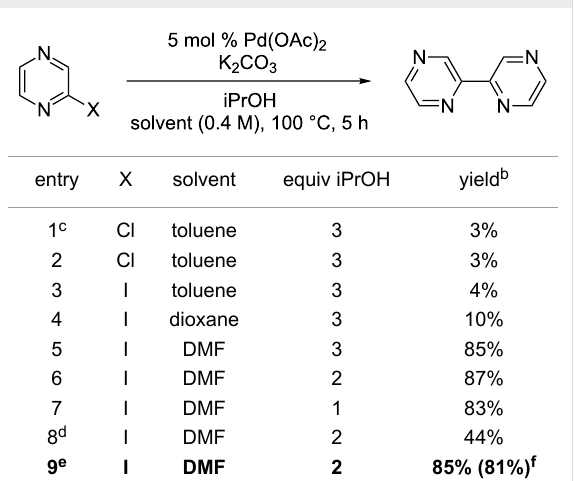
Table 1: Optimization of Pd-catalyzed reductive homocoupling of 2-halopyrazines.